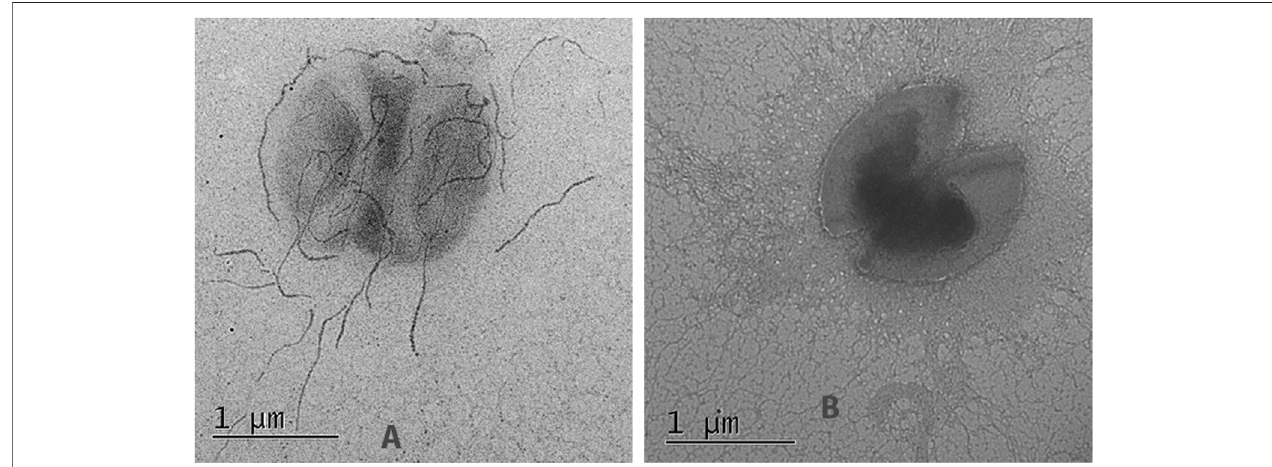
FIGURE7| Immunoelectronmicroscopyoftheoriginal( E,faecium L3)andgeneticallymodi fi edstrain(L3-SARS)afterdetectionwithpolyclonalserumfrompatients with COVID-19 with the following immunogold labeled goat IgG conjugated to 18 nm gold particles as described in Section 2.8. (A) strain L3-SARS. (B) E. faecium L3.